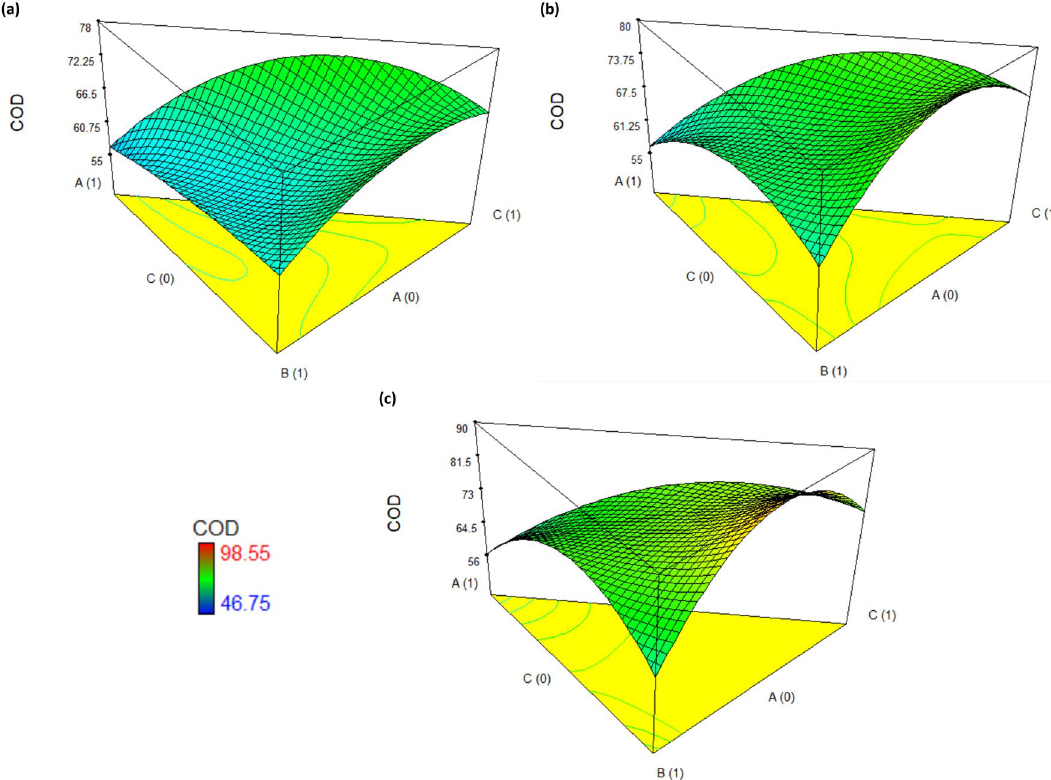
Figure 3. 3D response surface plots for the COD removal in ceramic industry wastewater using coagulant doses: ( a ) low-200 mg/L, ( b ) medium-500 mg/L, and ( c ) high-800